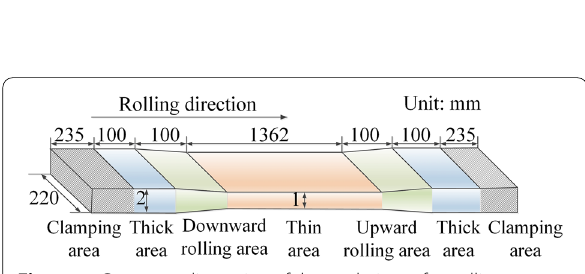
Figure 7 Geometry dimension of the workpiece after